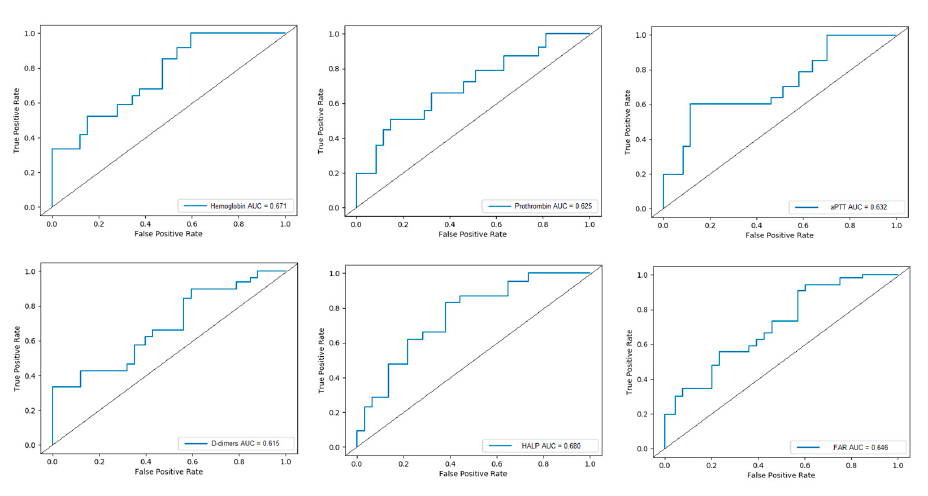
Figure 2. ROC plot for the variables involved in estimating the risk for preterm birth.